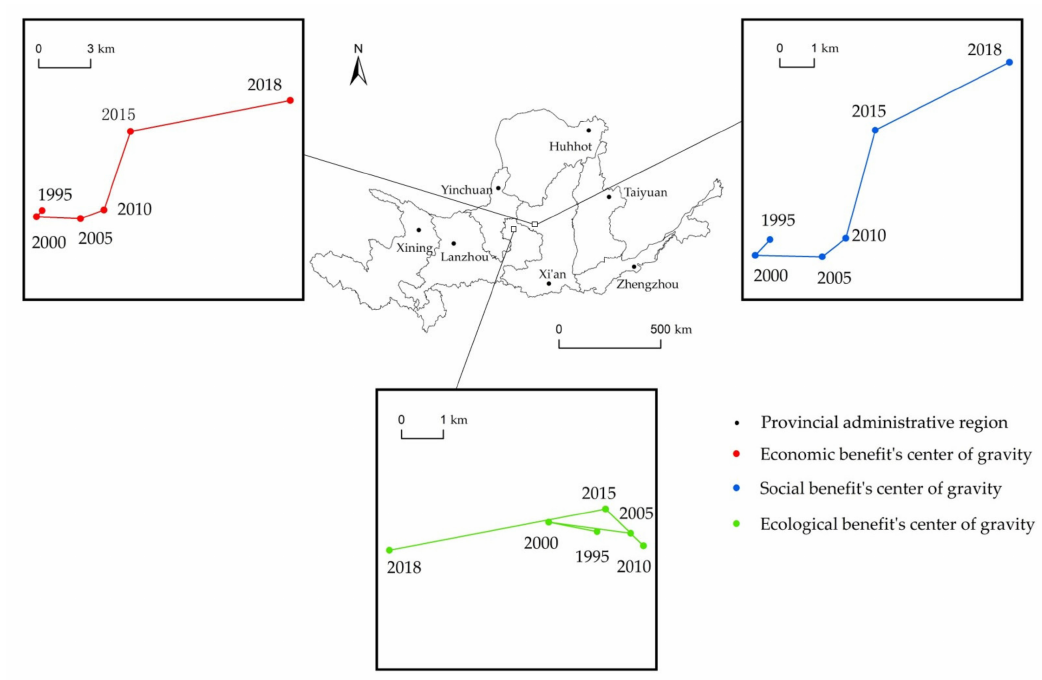
Figure 9. The shifts of the center of gravities of land use benefits in the Yellow River Basin from 1995 to 2018.